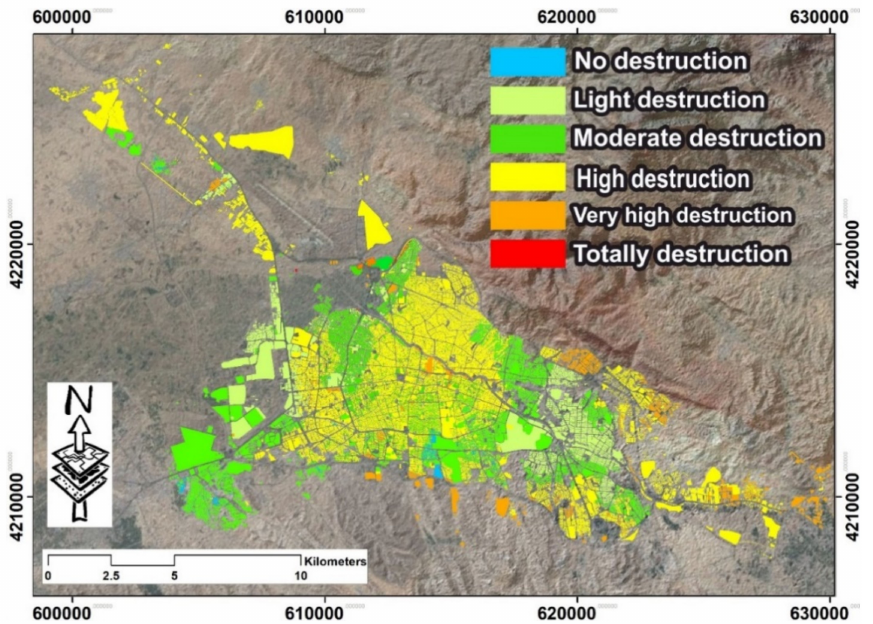
Figure 26. Extent of the destruction of the buildings according to their municipal area for the earthquake of 1780.